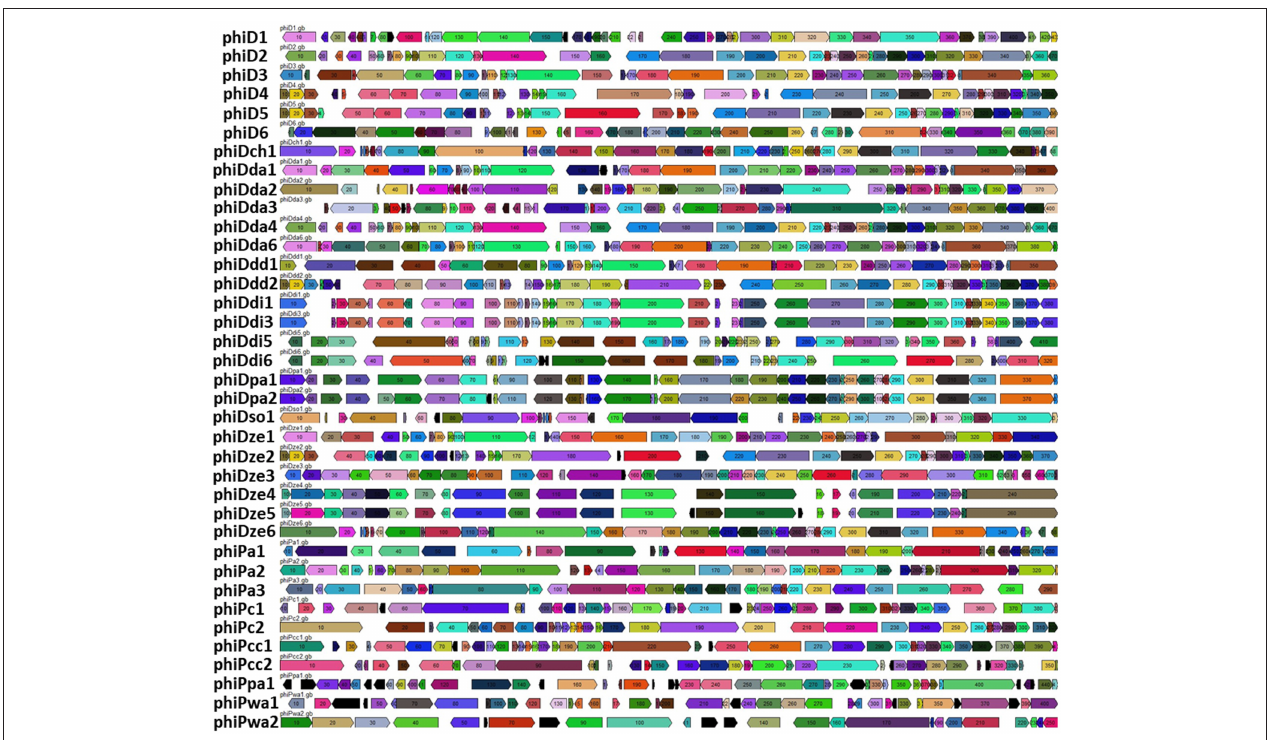
FIGURE 4 | Comparative analyses of the 37 intact prophage genomes. Boxes indicate open reading frames (ORFs) in prophage genomes predicted by RAST annotation pipeline. Homological ORFs are marked with the same color. The analysis and visualization were performed with the use of DNA Master ver.